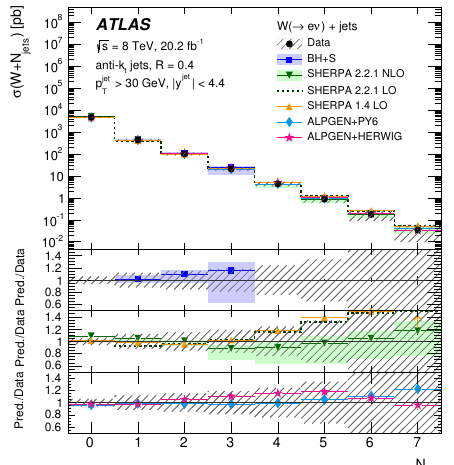
Figure 10 . Cross section for the production of W + jets as a function of exclusive jet multiplicity. For the data, the statistical uncertainties are indicated as vertical bars, and the combined statistical and systematic uncertainties are shown by the hatched bands. The uppermost panel in each plot shows the di(cid:11)erential cross sections, while the lower panels show the ratios of the predictions to the data. The theoretical uncertainties on the predictions are described in the text. The arrows on the lower panels indicate points that are outside the displayed range.